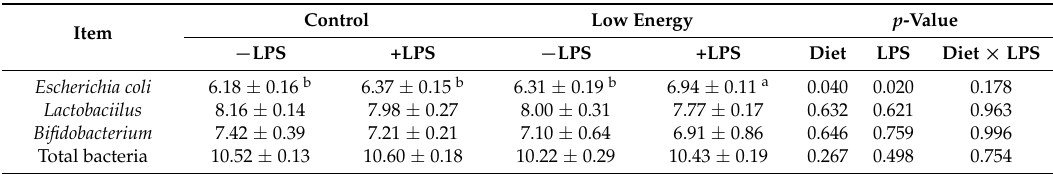
Table 11. Effect of different energy level during gestation on intestinal bacteria of weaned piglets challenged with Escherichia coli lipopolysaccharide.